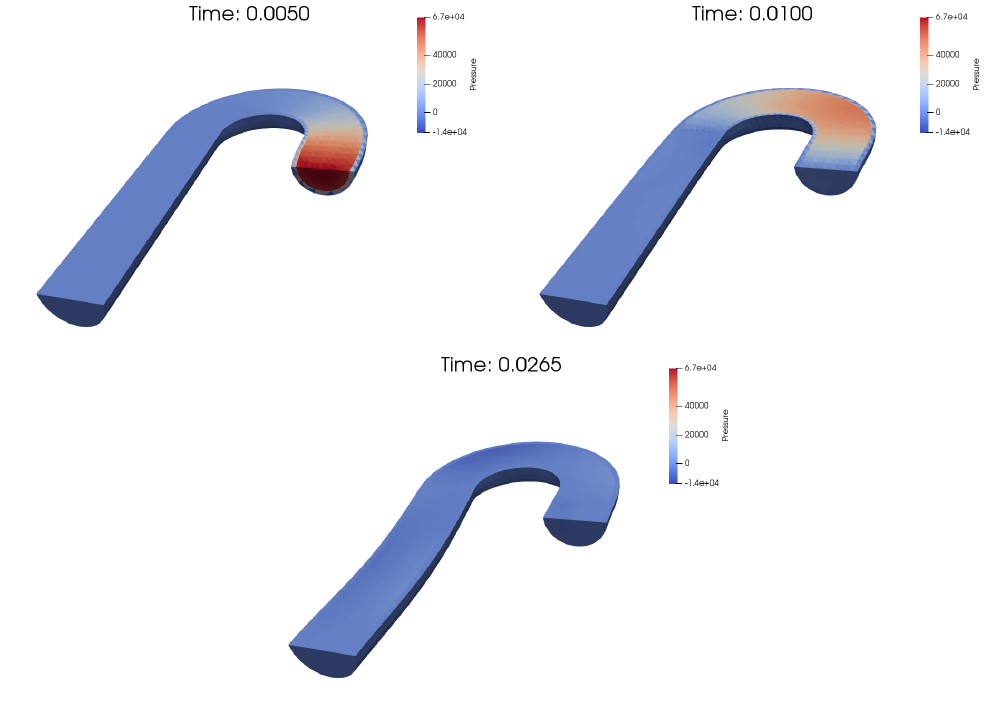
Figure 7. The computed pressure obtained with sin-like stress at the inlet (Mesh